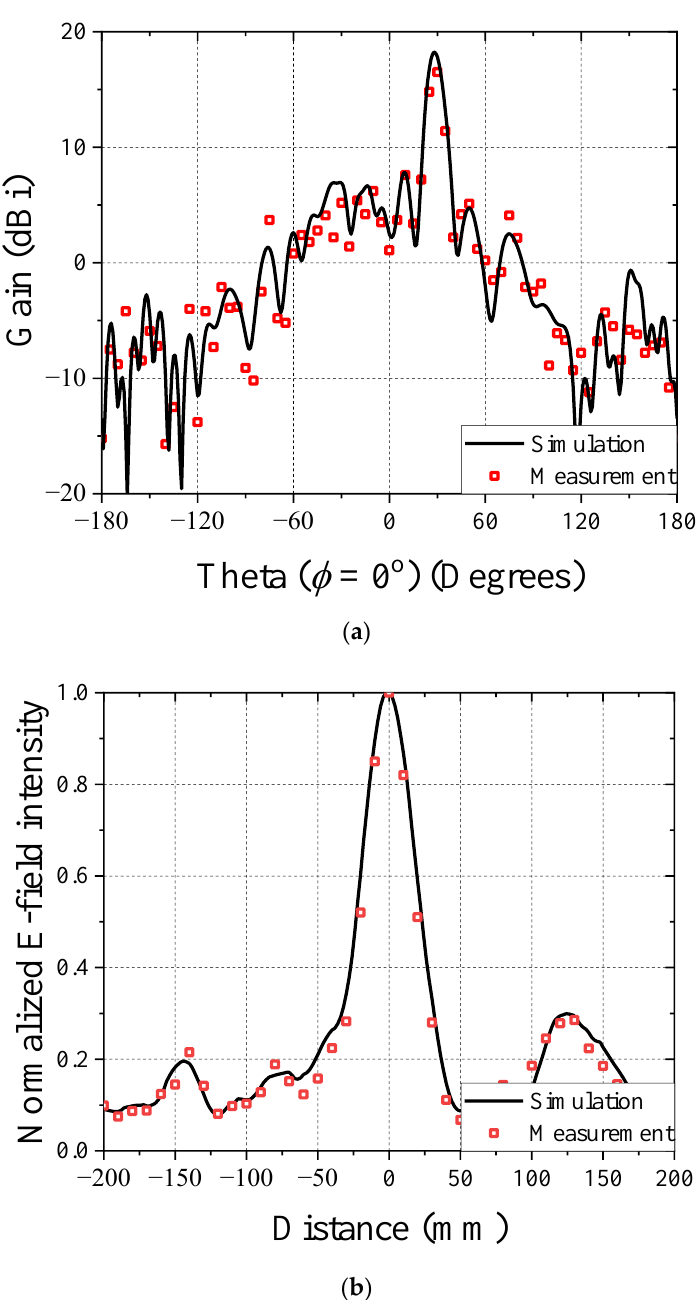
Figure 7. Performance of proposed antenna in far and near regions. ( a ) Far-field radiation pattern ( ϕ = 0°) ( b ) Normalized E-field intensity at x -axis.